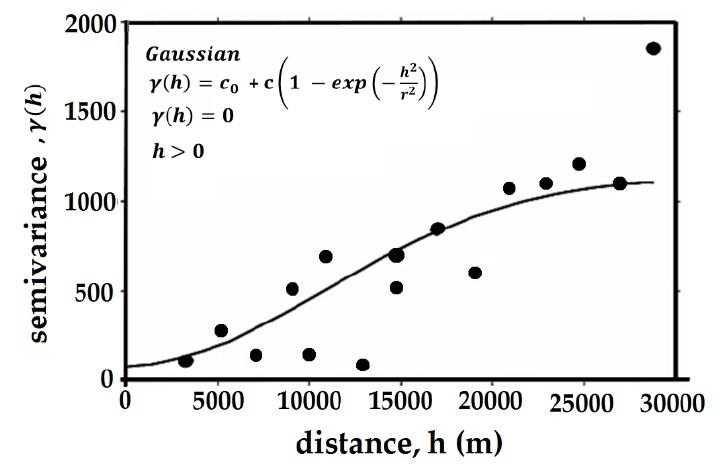
Figure 3. The omnidirectional semivariogram obtained by using the Gaussian variogram model for January 2006. The fitted parameters of the sill, nugget (C 0 ), and range are 1094, 85, and 15295 m, respectively.